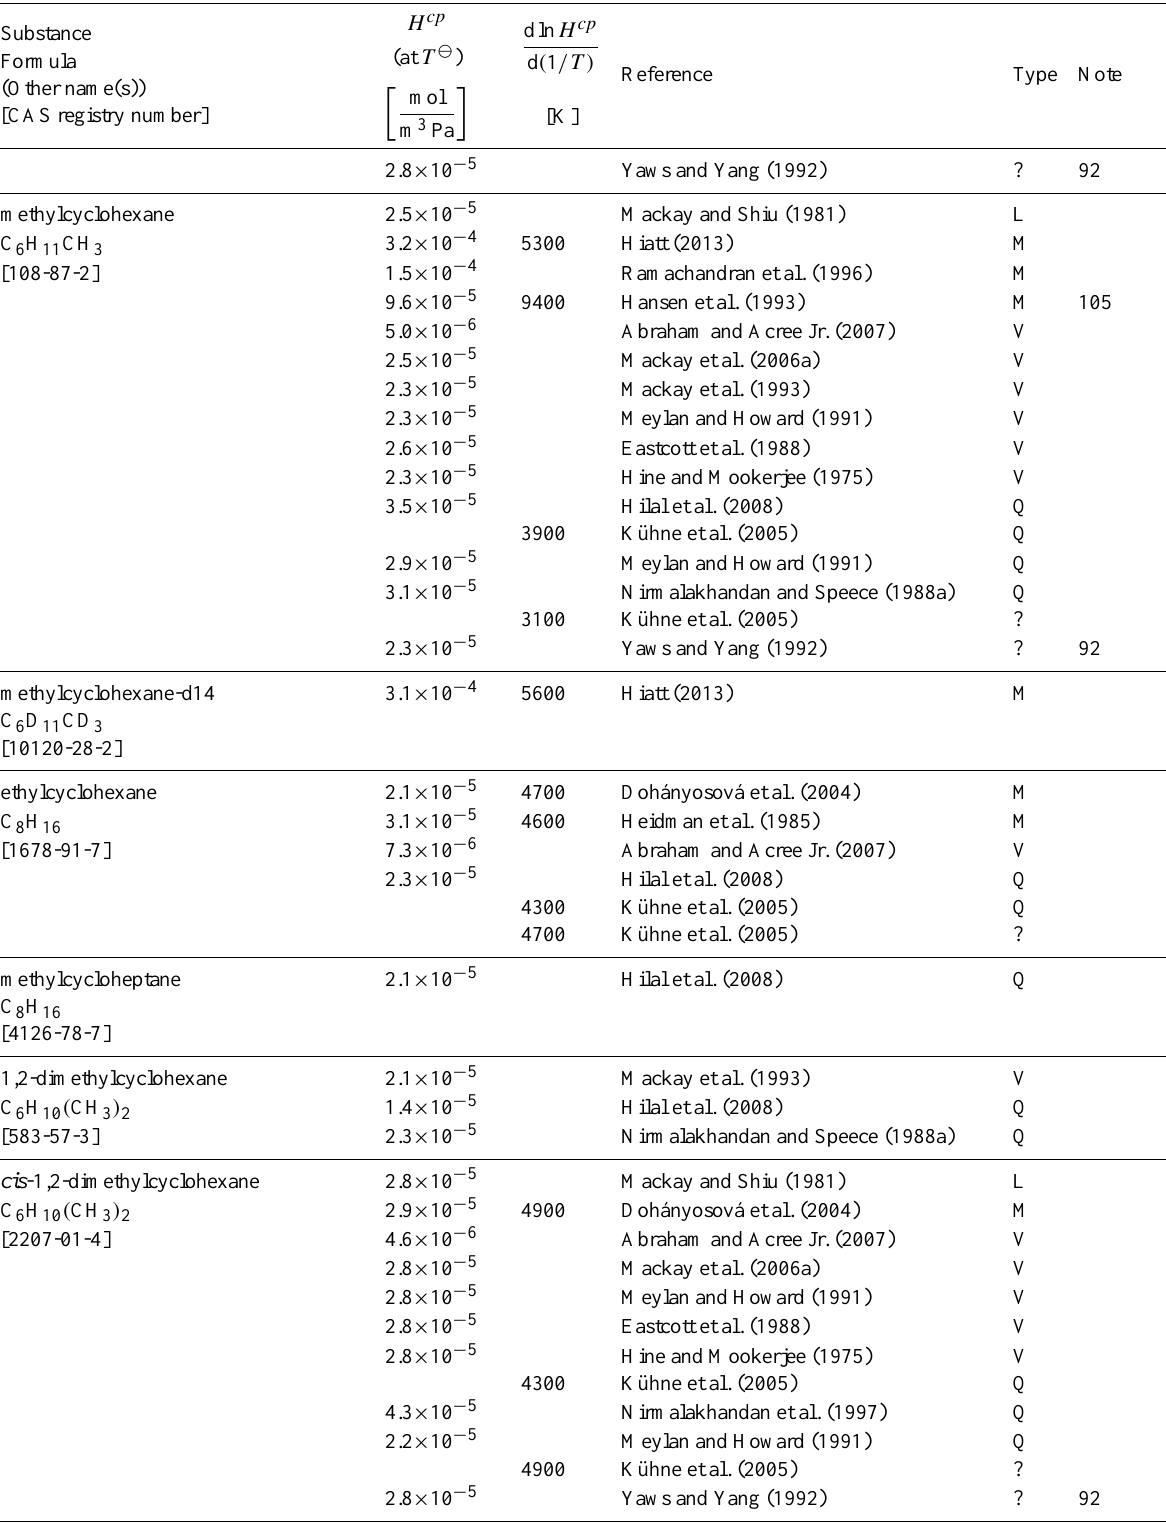
Table 6: Henry’s law constants for water as solvent